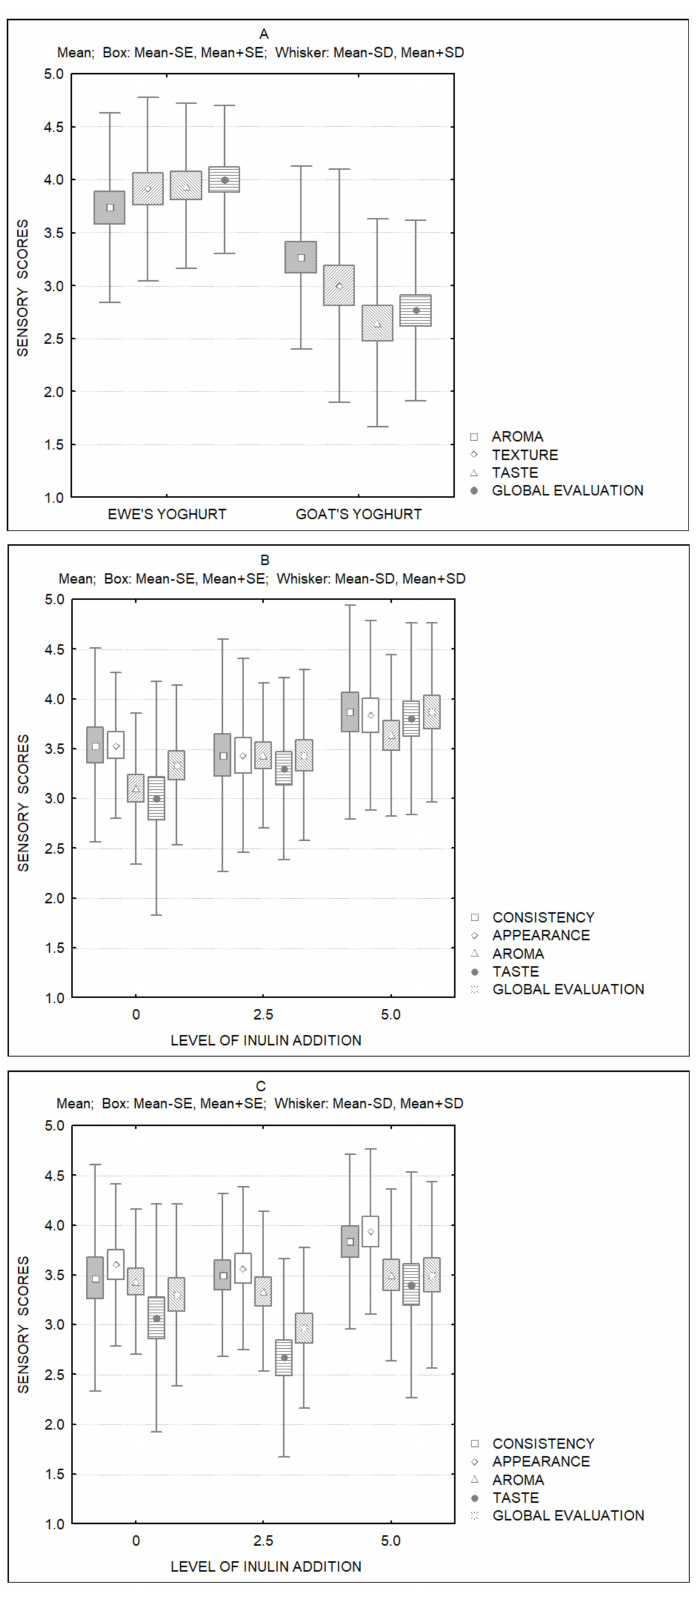
Figure 8. Sensory scores of ewe’s and goat’s yoghurts and correspondent frozen yoghurts produced with UF concentrated cheese whey (( A ) = ewe’s and goat’s yoghurts; ( B ) = ewe’s frozen yoghurts, ( C ) = goat’s frozen